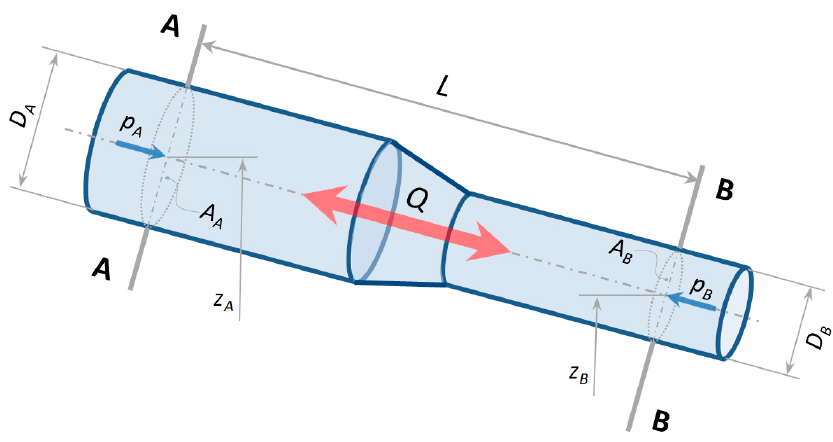
Figure 4. Scheme of the penstock measuring section with markings.